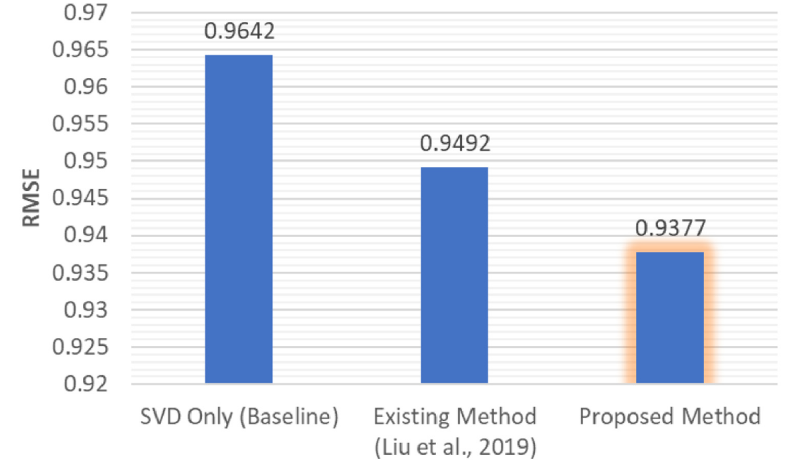
Figure 5. Lowest RMSE value comparison between various